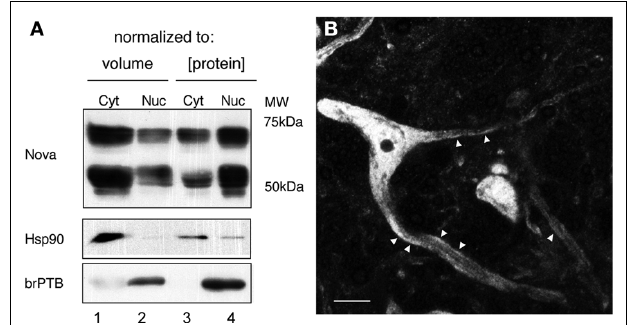
FIGURE 1 | Subcellular distribution of Nova proteins. (A) Immunoblot analysis of Nova distribution in cytoplasmic and nuclear fractions from mouse brain (equal volumes (20 µl) of each fraction were loaded in lanes 1 and 2; equal protein amounts (50 µg) were loaded in lanes 3 and 4). Hsp90 is used as a cytoplasmic marker, and brPTB as a nuclear marker. The antibody used detects both Nova 1 ( ∼ 55 kD) and Nova-2 ( ∼ 75 kD) isoforms. (B) Nova signal is detected within the nucleus, somatic cytoplasm, and neurites of ventral horn spinal cord neurons. Within neurites, the signal is observed along the plasma membrane (arrowheads). Scale bar: 10 µm (B)